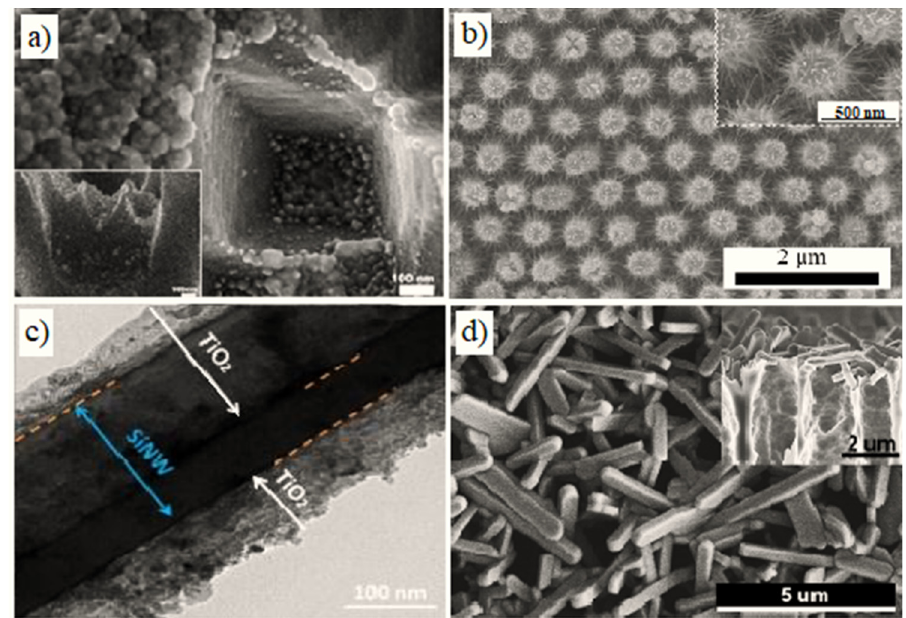
Figure 5. Scanning electron microscopy (SEM) images of some nano-Si/MOx nanocomposites: ( a ) SEM images of the PSi/ZnO nanocomposite [125]; ( b ) SEM images of the SiNWs/WO 3 nanocomposite [126]; ( c ) SEM image of the SiNPs/TiO 2 nanocomposite [136]; ( d ) SEM images of the PSi/V 2 O 5 nanocomposite [37].